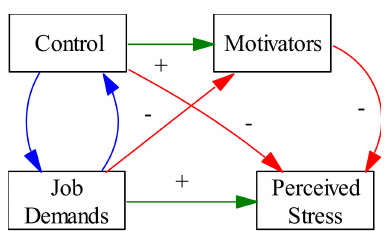
Figure 1. Job Demands–Control (JD–C) model (adapted from Wallgren and Hanse, 2007 [21]). Note: blue arrows indicate co-varying determinants, green arrows indicate positive causal relations, and red arrows indicate negative causal